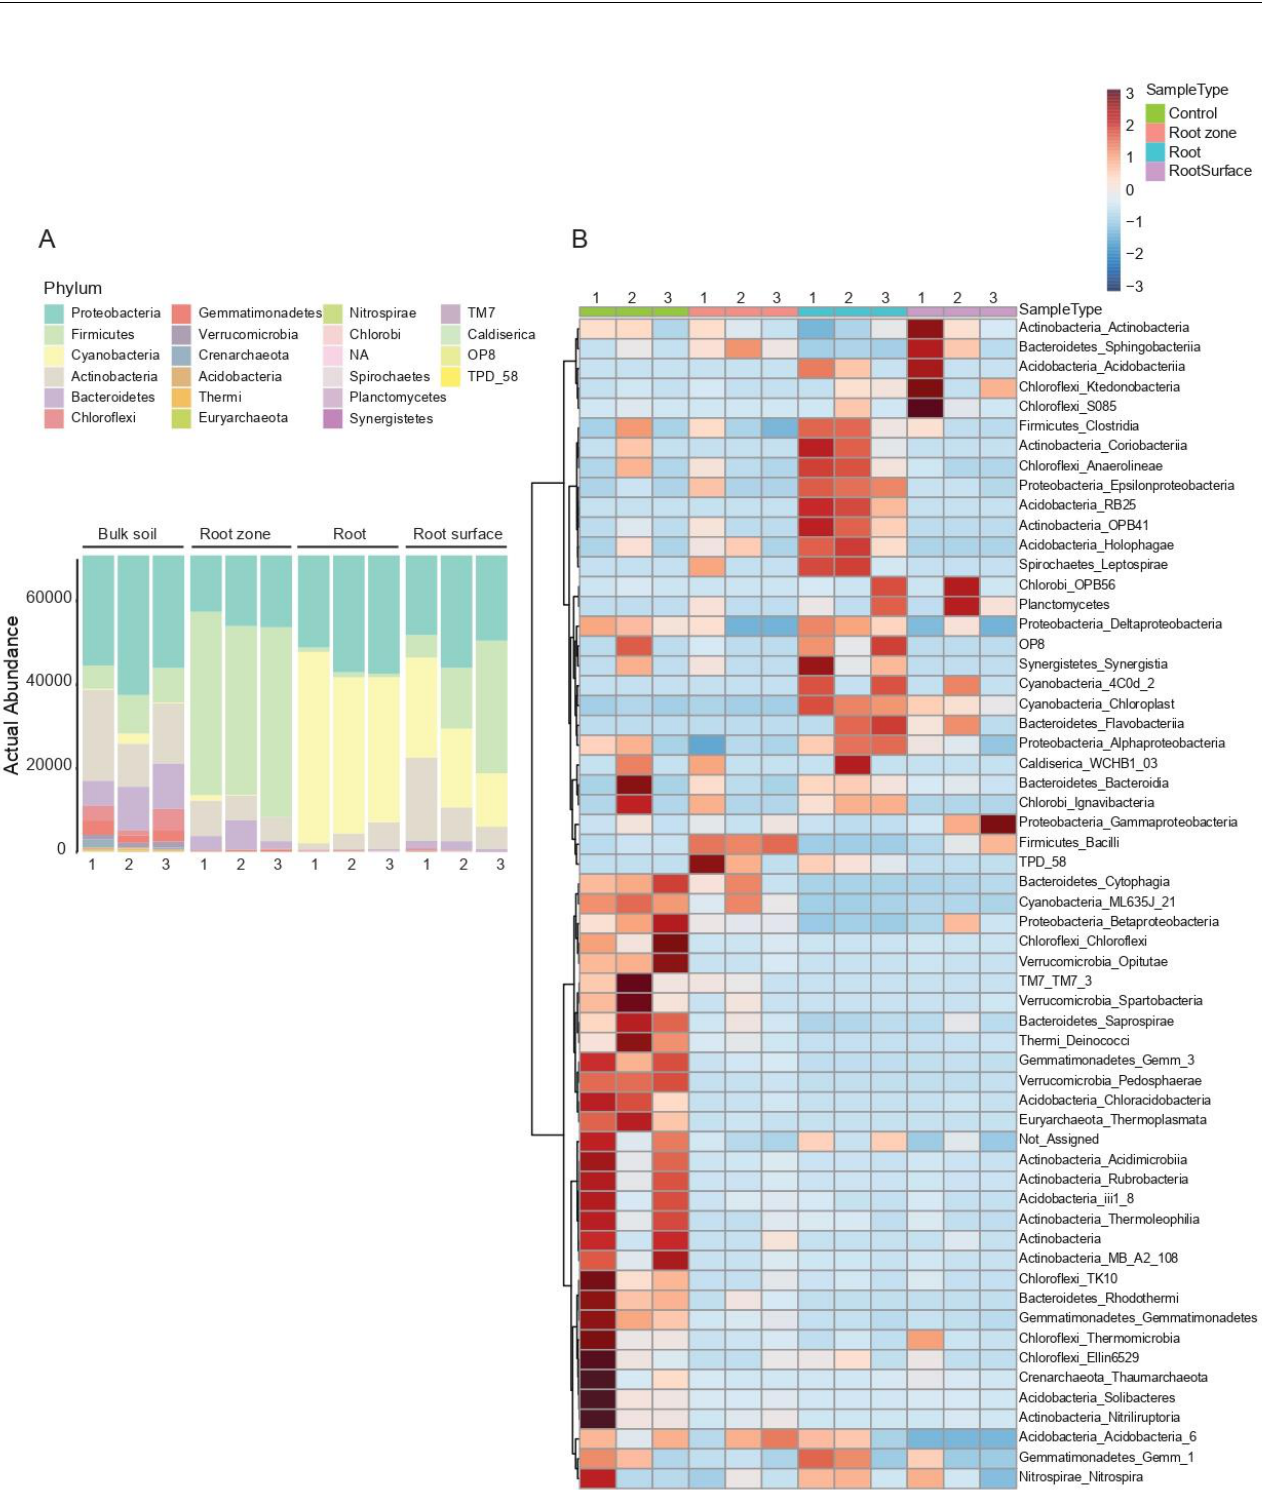
Figure 3. ( A ) Actual abundance at the phylum level of root and soil samples between three different C. colocynthis plants. ( B ) Heatmap of taxonomic composition at the Class level of root and soil samples between three different C. colocynthis plants. Labels are Phylum_Class, based on Greengenes Taxonomy reference base.